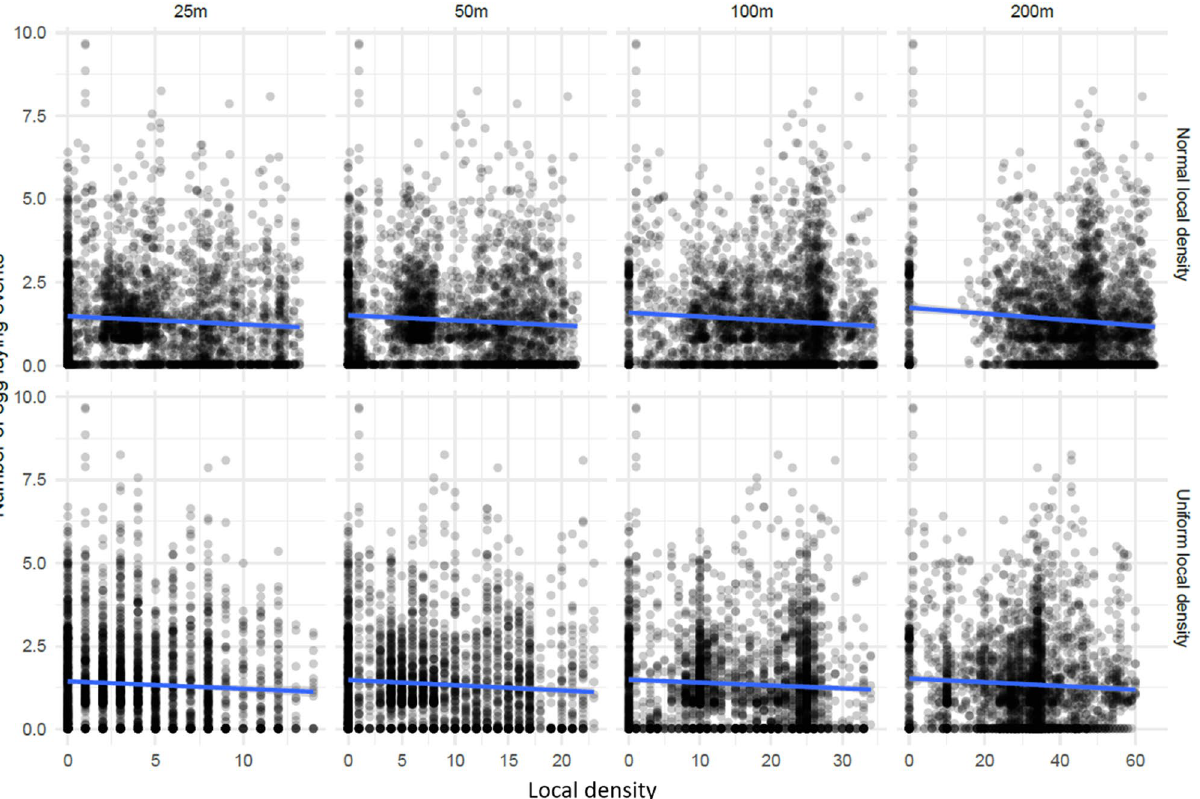
Figure 6. Number of inferred egg laying events and the local density of ovitraps in the previous week. This plot shows the number of inferred egg-laying events by the local density of ovitraps in the previous week for all ovitraps. The rows correspond to the Normal and Uniform local density models and the columns give the distance parameter for those models. The x-axis can be loosely interpreted as the number of other ovitraps that are within about the specified number of meters of the given ovitrap. The blue line shows the predicted mean of the linear model of the